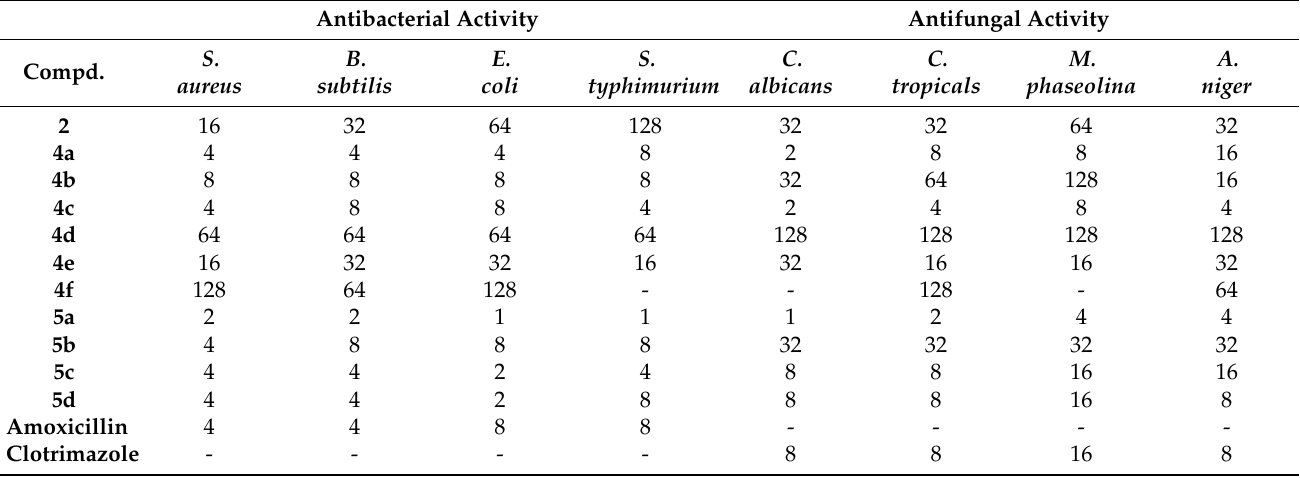
Table 2. In vitro antimicrobial activities of the synthesized quinazolin-4(3 H )-one derivatives as minimum inhibitory concentrations (MIC) in µ